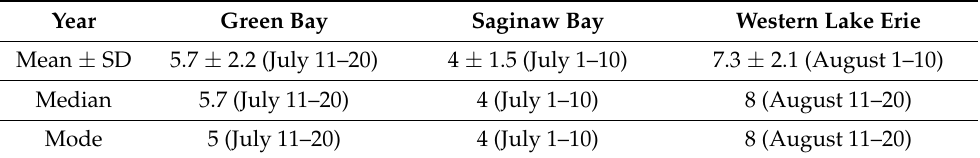
Table 3. The 10-day composite periods (dates in parentheses) exhibiting the start date of the blooms. This was given as the time when the integrated CI cyano value (that is a summed CI cyano from every pixel within a basin) reached a value of one. If a basin never achieved an integrated value of one in a given year, the CI max was used as the start date for that particular year.